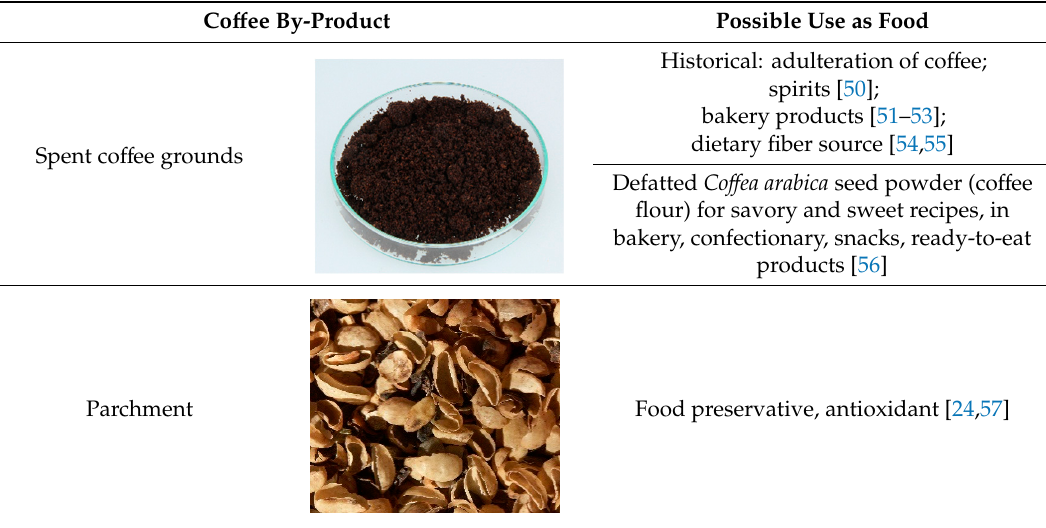
Table 1. Cont . Co ff ee By-Product Possible Use as